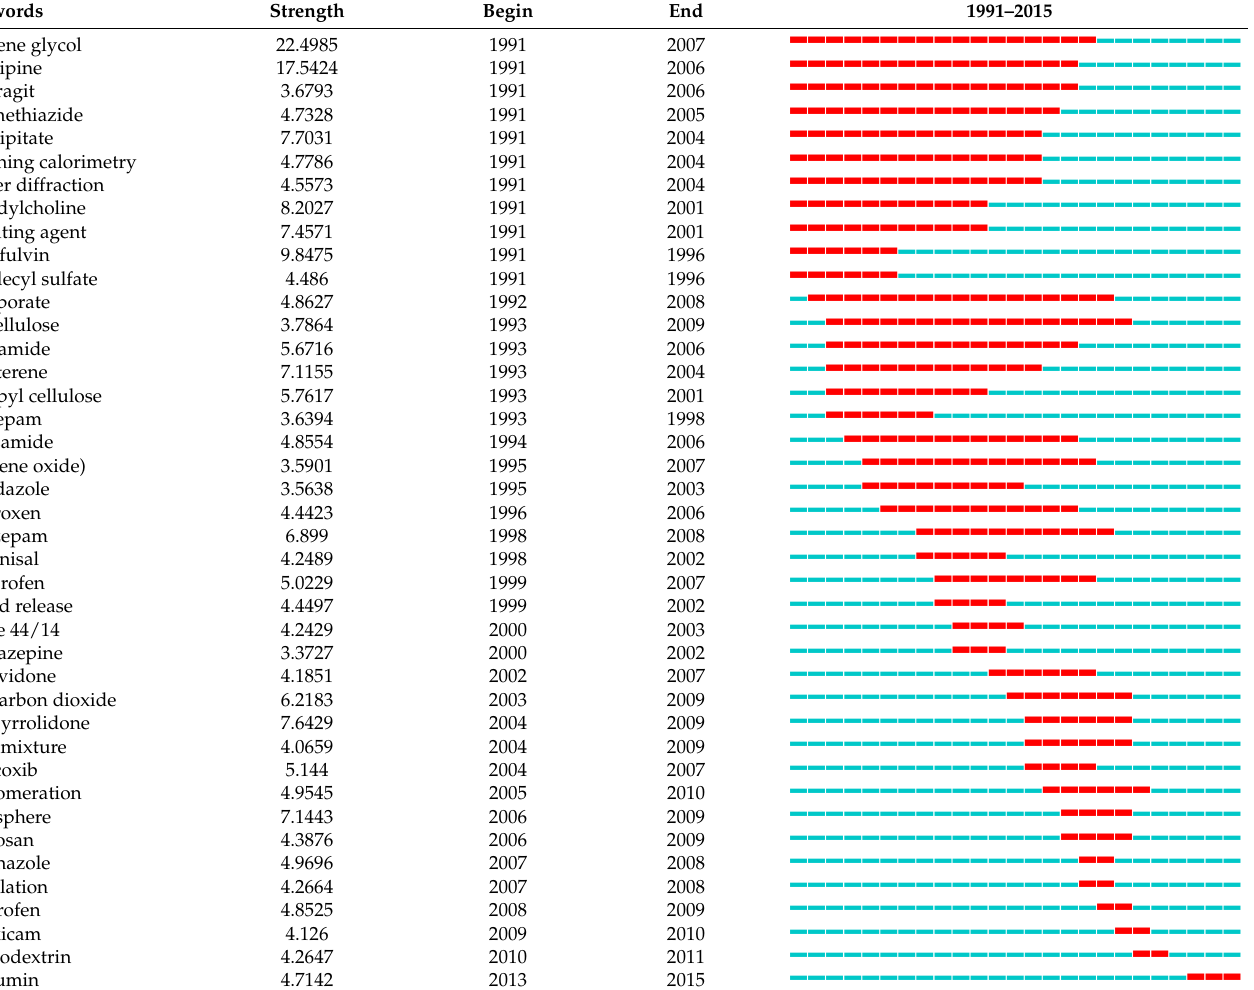
meant the key word burst emergence in this period.